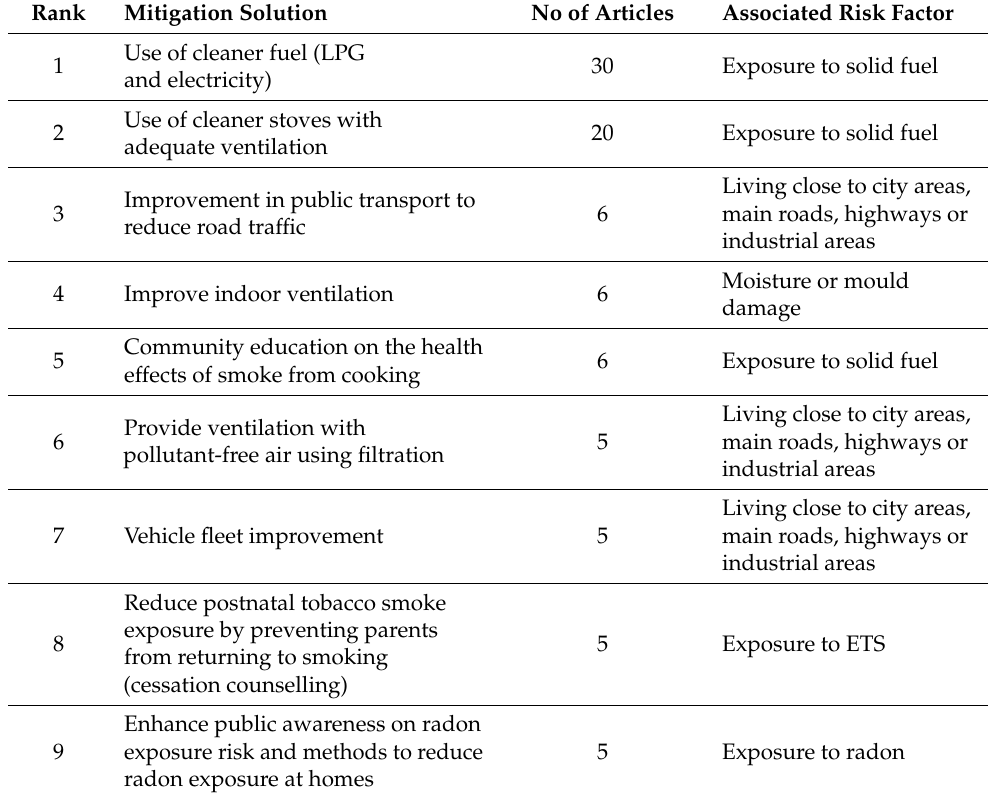
Table 4. Top nine mitigation measures proposed in the current